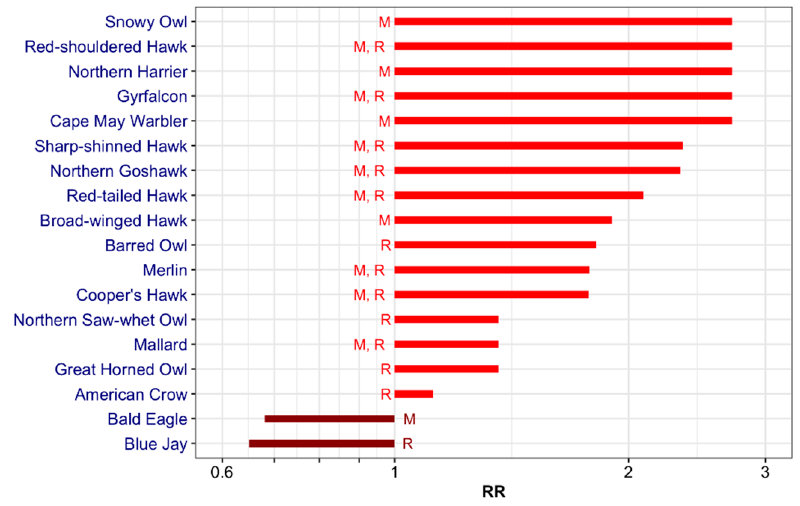
Figure 3. List L 1 : ranked list ( n = 18) of dead birds found by WNV passive bird surveillance. RR stands for relative risk or ratio of dead birds found positive for WNV. Quoted letters “M” and “R” stand for migratory and resident birds, respectively.